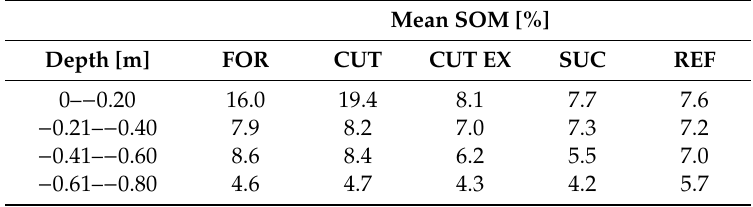
Table 6. Mean soil organic matter (SOM) content. Depth aggregated